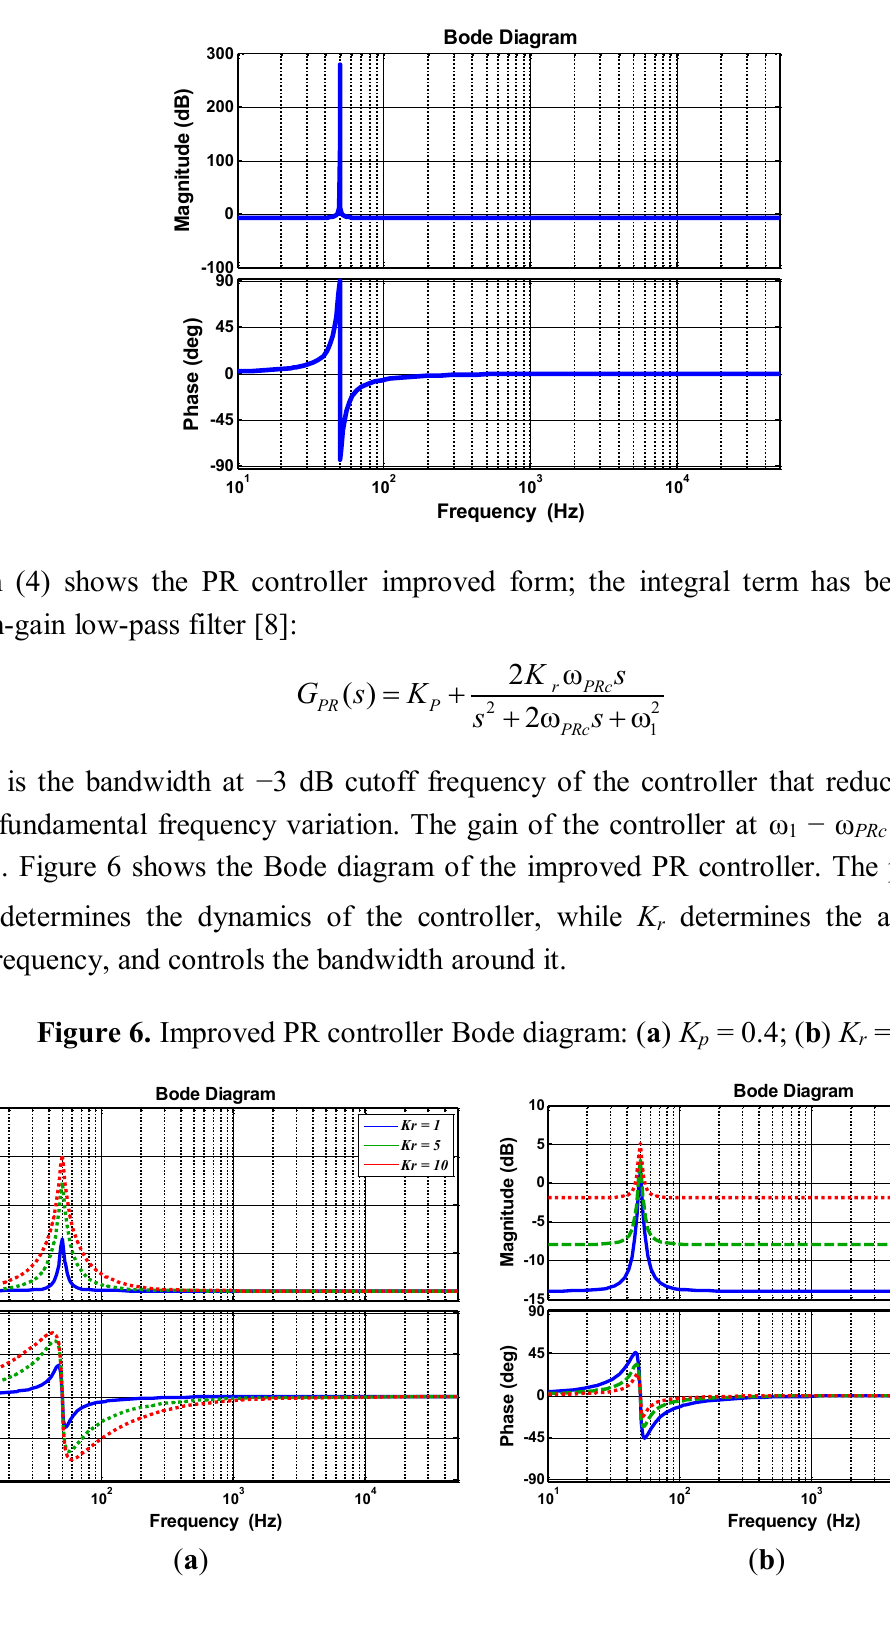
Figure 5. Ideal PR controller Bode diagram.